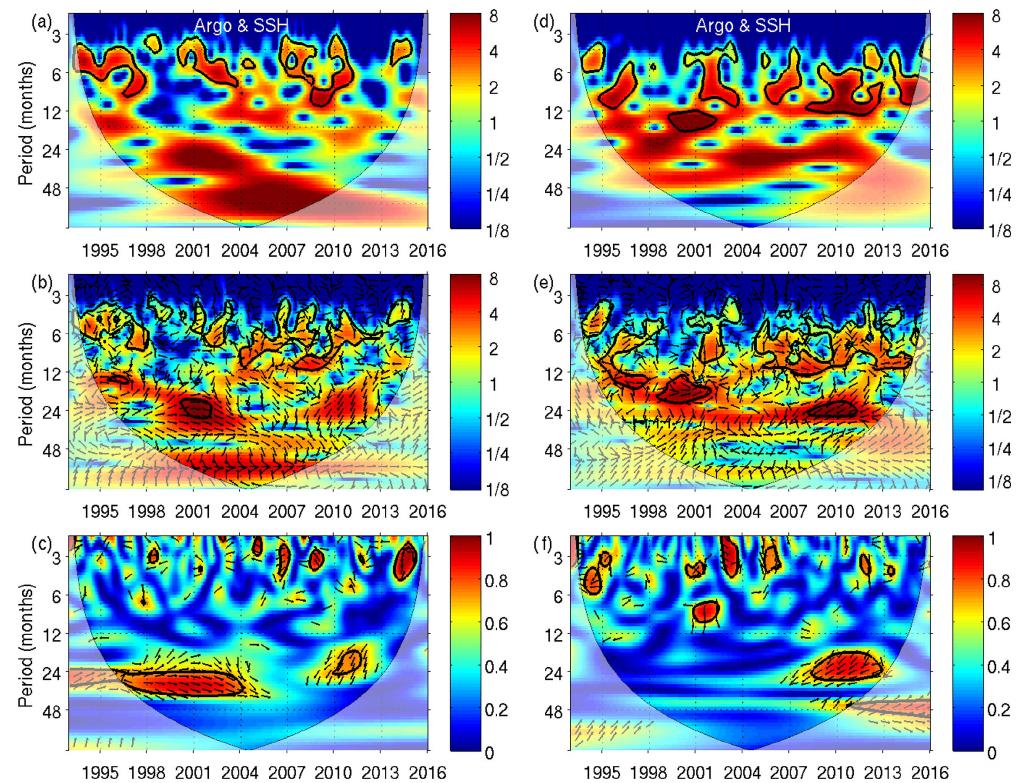
Figure 8. Wavelet power spectrum at 35 ◦ S (a–c) and 38 ◦ S (d–f) for the Brazil Current transport from Argo&SSH (a, d) . Panels (b) and (e) show the cross wavelet power spectrum between SAM (Fig. 7b) and the Brazil Current transport from Argo&SSH for these two latitudes. Panels (c) and (f) show corresponding the coherences. The vectors in the lower panel indicate the phase difference between them. The thick black line is the 5% significance level using the red noise model, and the thin black line indicates the cone of influence. The time series were smoothed in the same way as the time series of the Brazil Current transport in Fig.